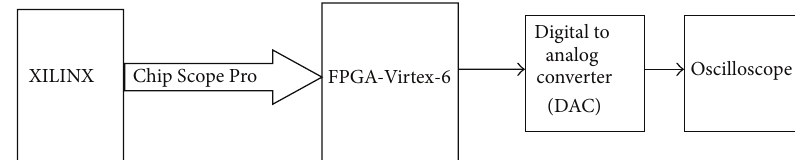
Figure 1: FPGA implementation.